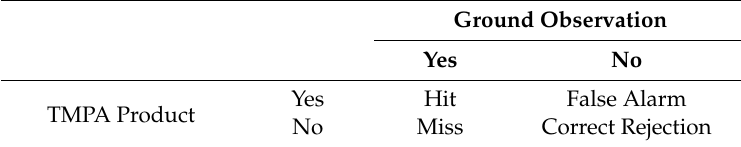
Table 2. Contingency table to measure the correspondence between ground observation data and Tropical Rainfall Measurement Mission Multi-satellite Precipitation Analysis (TMPA) product concerning the threshold intensity of 0.6 mm/day of a point-to-point event